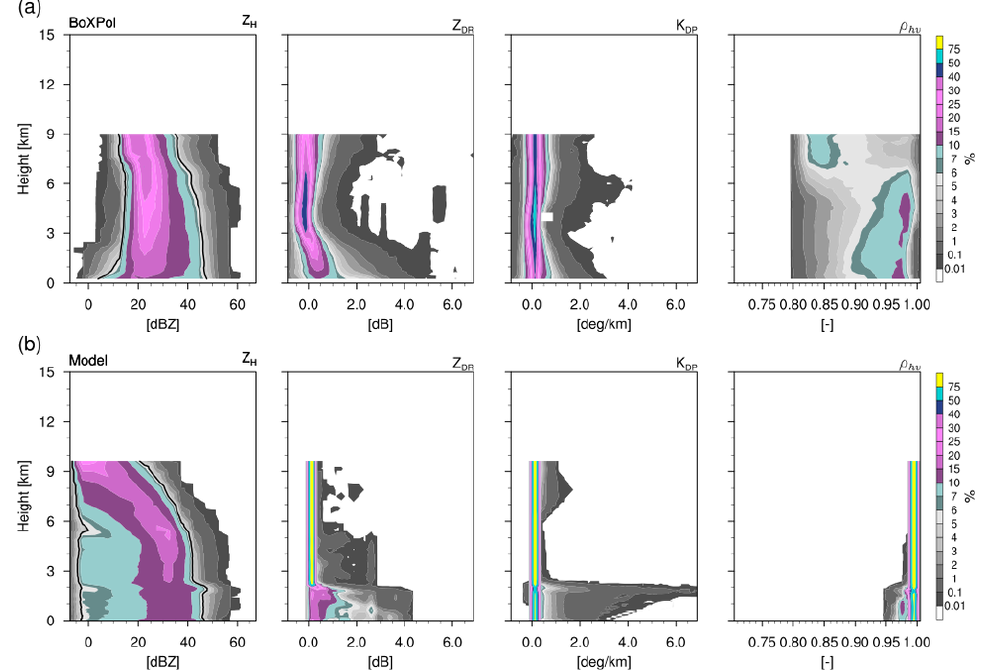
Figure 12. CFADs of horizontal reflectivity, differential reflectivity, specific differential phase and cross-correlation coefficient from 10:10 to 10:55UTC on 13 May 2016. CFADs from the model are shown for five ensemble members from 10:30 to 11:15UTC.